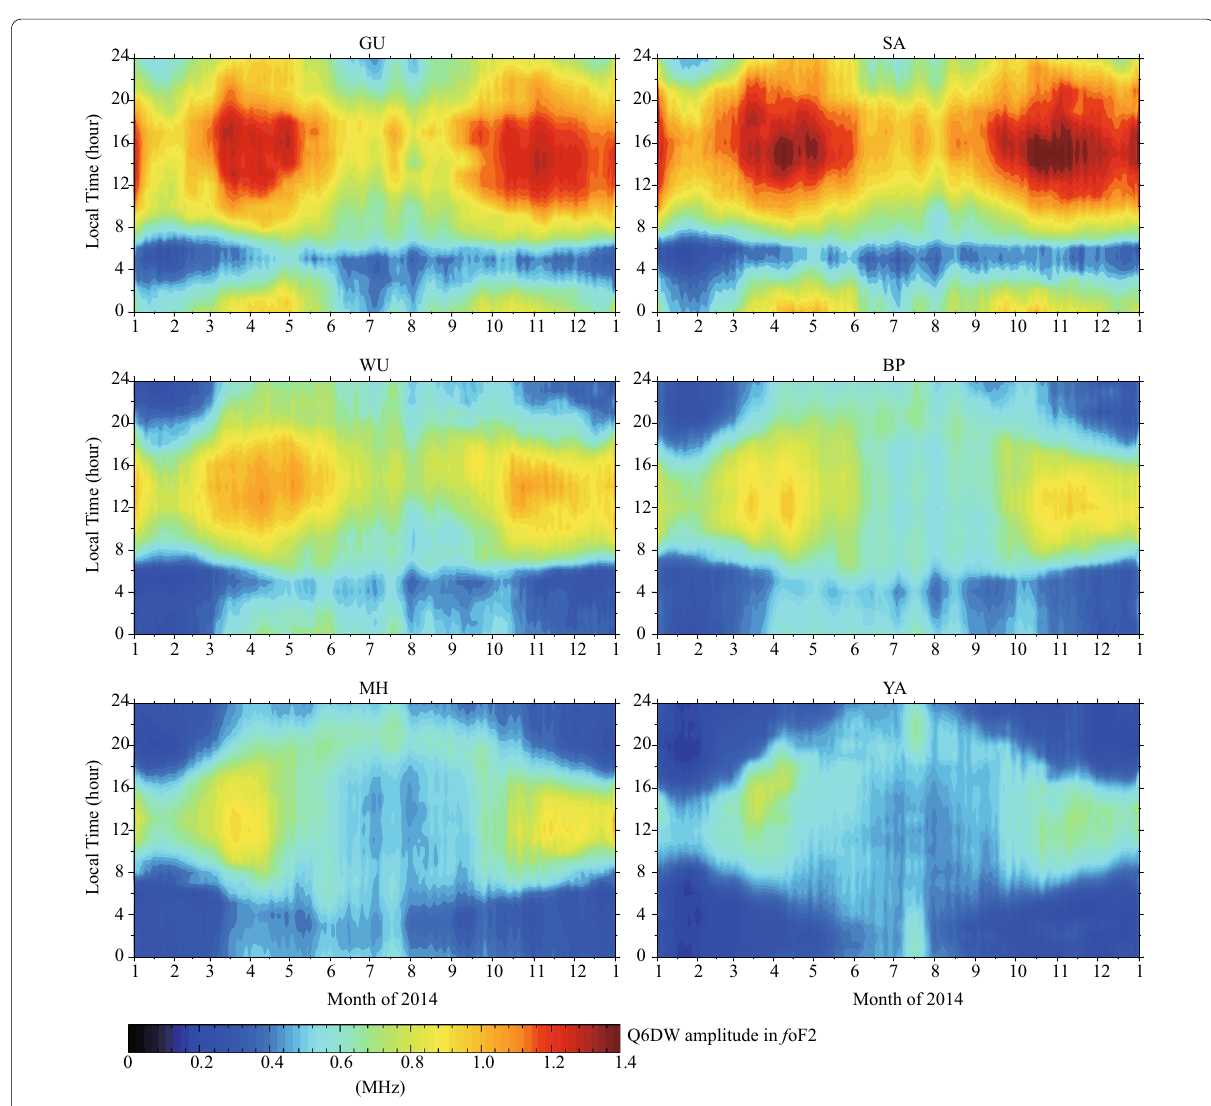
Fig. 8 Average amplitude of Q6DW (s 1) in f oF 2 during 2014 at Guam (GU), Sanya (SA), Wuhan (WU), Beijing (BP), Mohe (MH) and Yakusk =